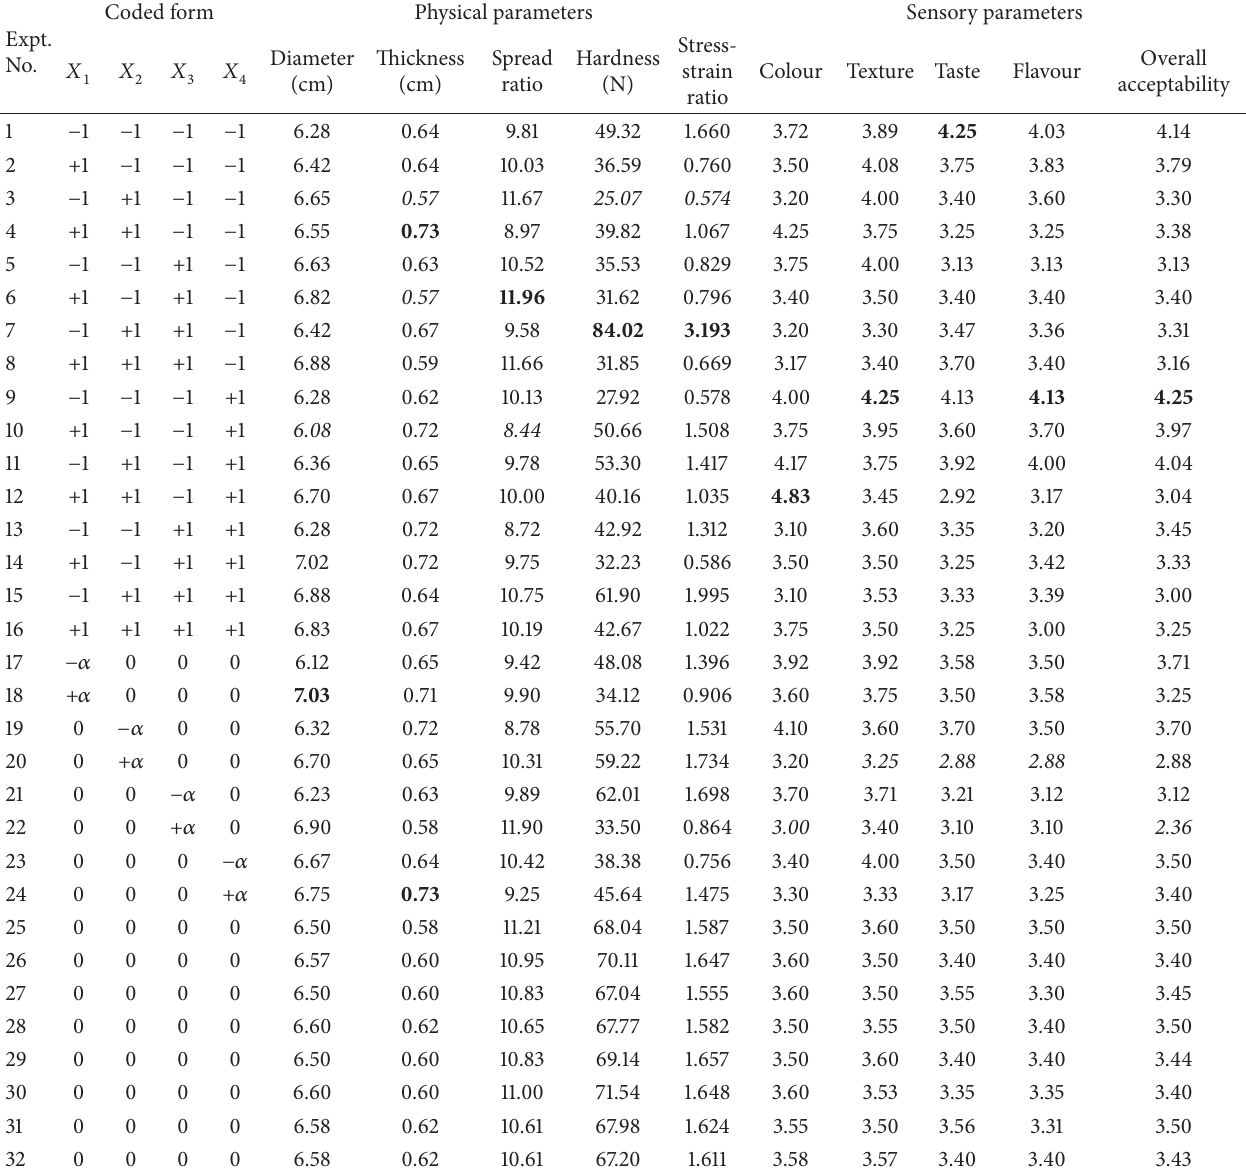
Table 1: Experimental design matrix for manufacture of low-fat